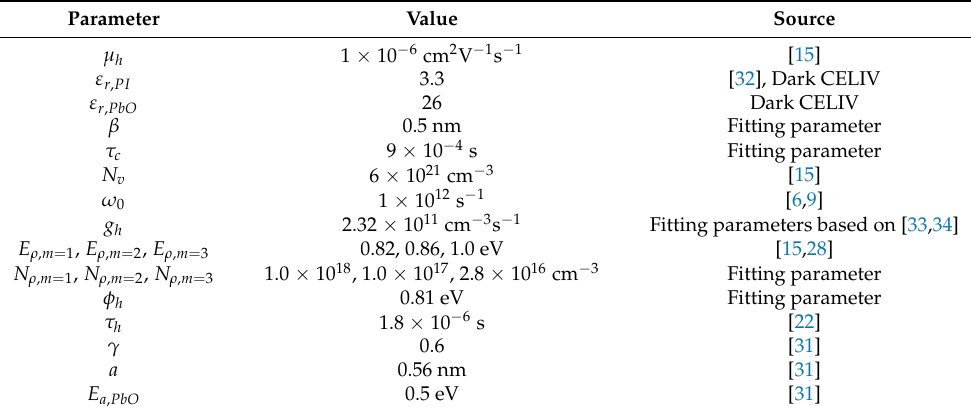
Table 1. Parameters, and their sources, utilized within the mathematical model in this investigation.